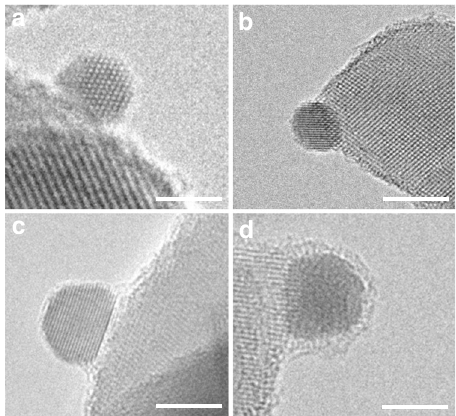
Fig. 1 HRTEM analysis. a HRTEM image of Au/TiO 2 . b HRTEM image of Au/TiO 2 @M. c HRTEM image of Au/TiO 2 @M-N. d HRTEM image of Au/ TiO 2 @M-N-800. The scale bar corresponds to 5 nm. Additional results for these samples can be found in Supplementary Figs. 1 –